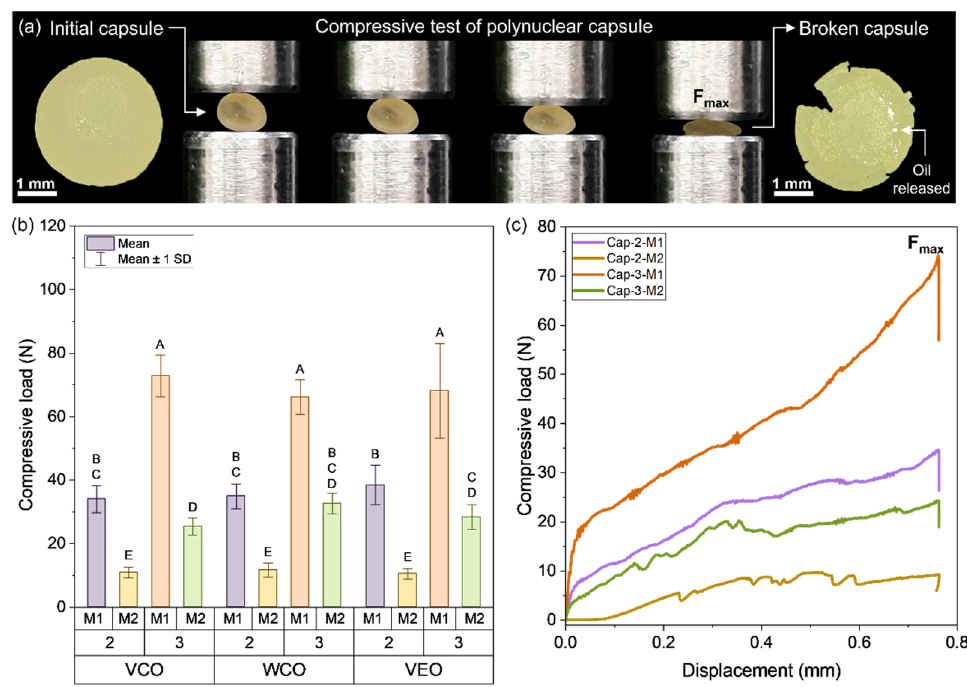
Figure 8. ( a ) Representation of the compressive test carried out on each capsule design; ( b ) average results of the maximum compressive load resisted by each capsule design; ( c ) representative compressive load curves for the capsules depending on the alginate concentration and used method.